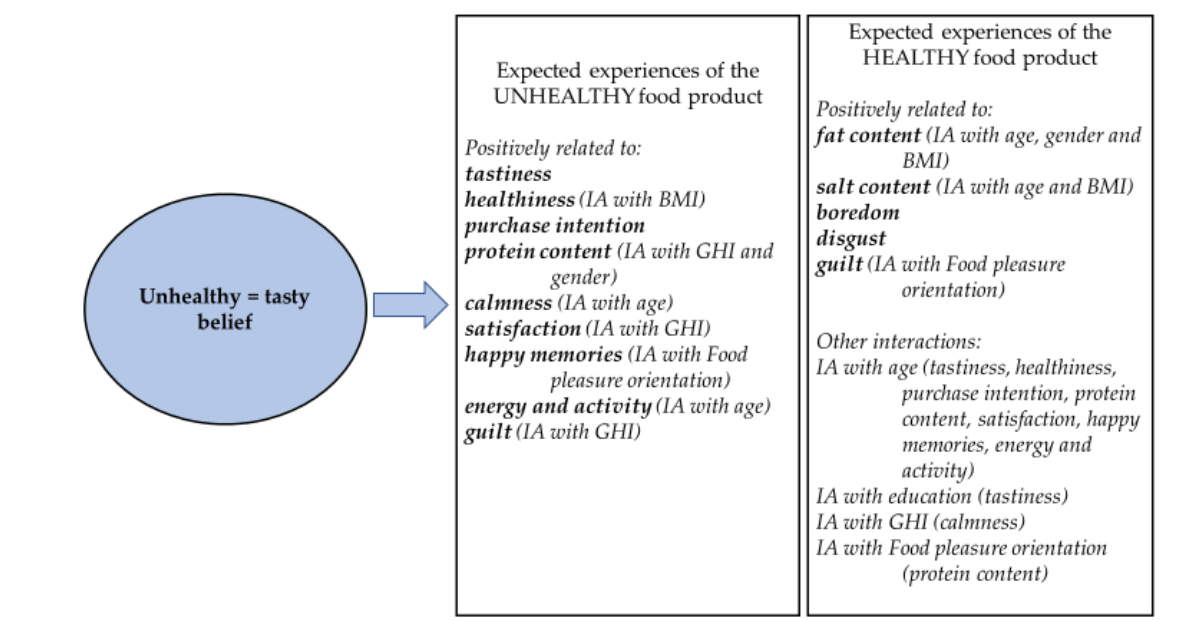
Figure 5. The effect of unhealthy = tasty belief on the expected experiences of the food products having different health image (see Sections S3 and S4). IA = interaction between UT belief and another factor.